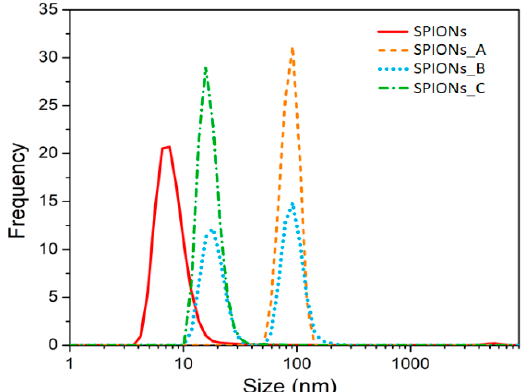
Figure 2. Size distribution obtained by DLS technique of diluted SPIONs and after the functionalization with increasing cyclohexane diamine concentration. Each distribution is the average of three measurements.